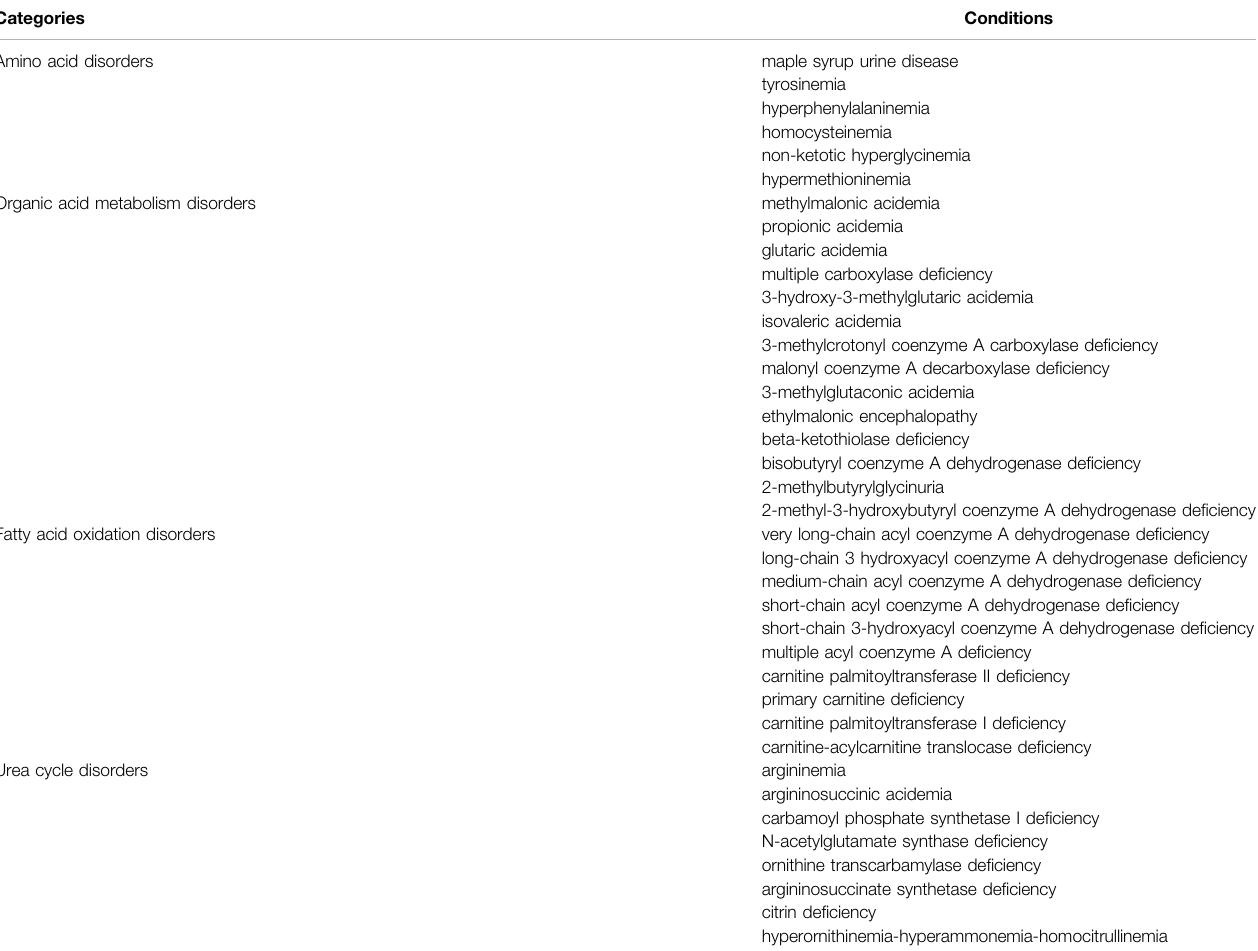
TABLE 1 | The newborn screening panel in the MS/MS NBS participating centers/laboratories of